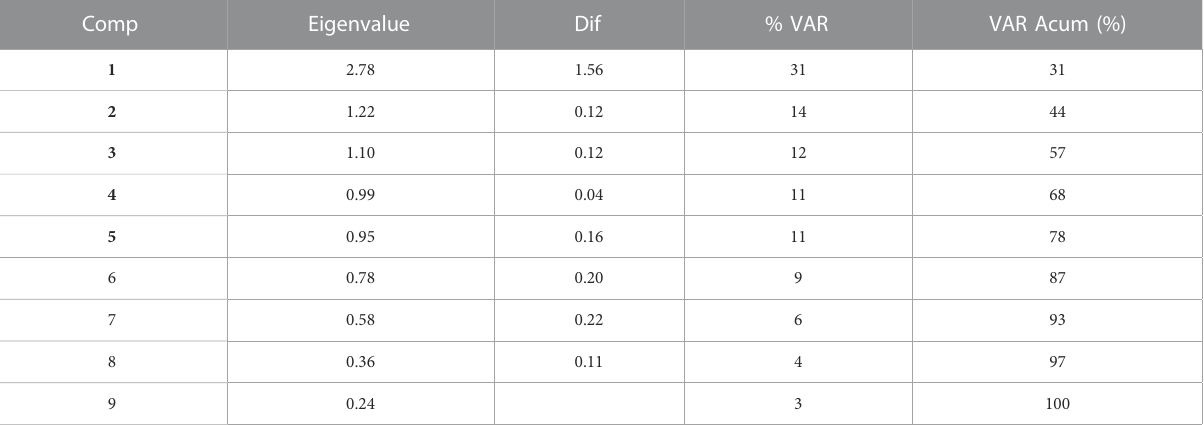
TABLE 6 Eigenvalues and explained variances for components of